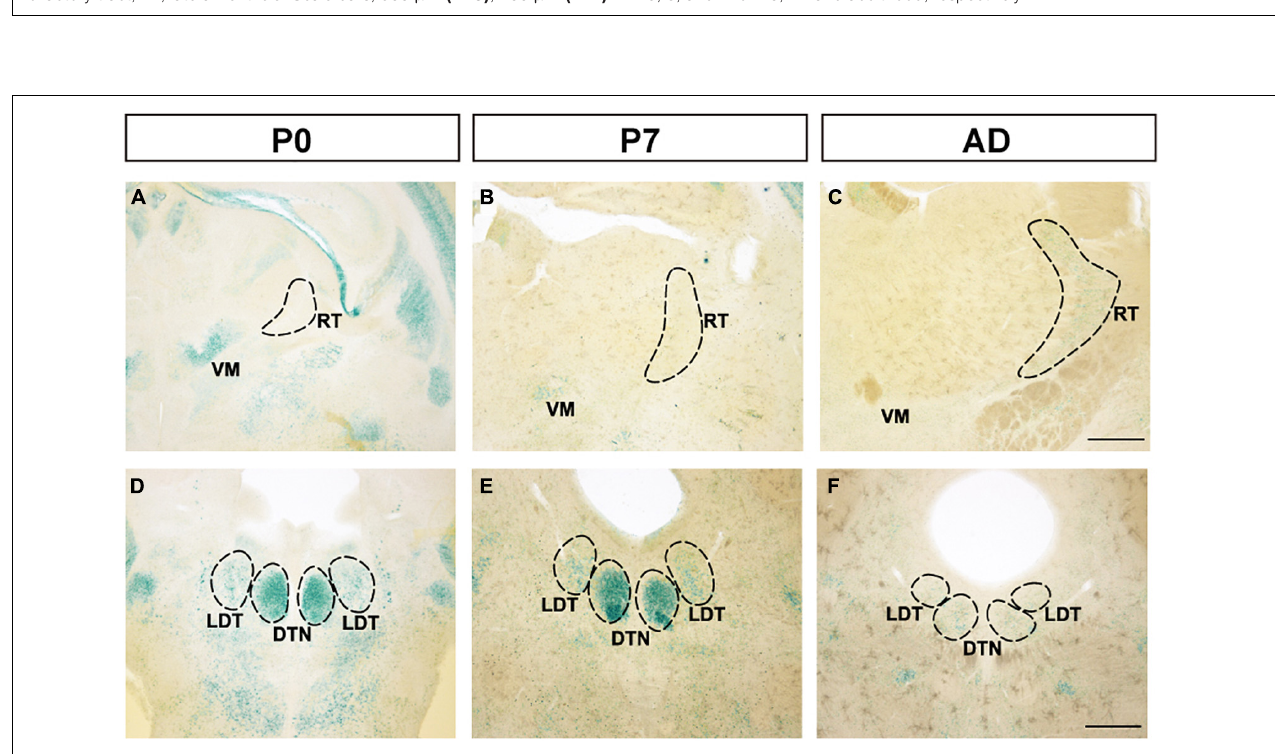
FIGURE 4 | Expression patterns in the thalamus and midbrain at P0, P7, and adulthood, revealed by X-gal staining. (A–C) FLRT2 expression levels changed from absent to weak in the ventral medial nucleus of the thalamus (VM) and from strong to weak in the reticular nucleus of the thalamus (RT) during development. (D–F) In the dorsal tegmental nucleus (DTN), expression of FLRT2 was high at P0 and P7, but decreased by adulthood. DTN, dorsal tegmental nucleus; LDT, laterodorsal tegmental nucleus; RT, reticular nucleus of the thalamus; VM, ventral medial nucleus of the thalamus. Scale bars, 500 µ m (A–F) . n = 3, 3, and 4 for P0, P7 and adulthood,